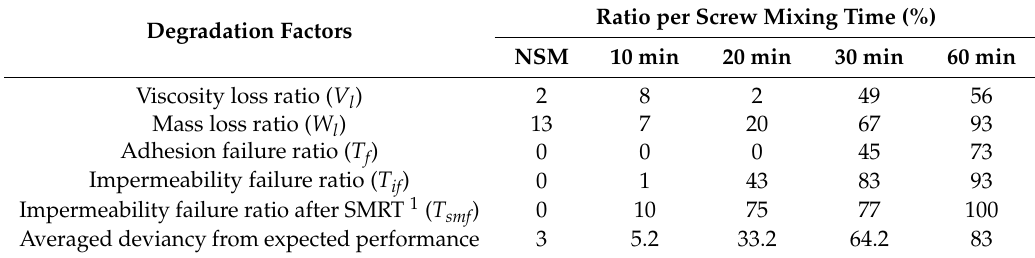
Table 7. Estimation of the deviancy from the expected performance of SPRG (2 h storage).